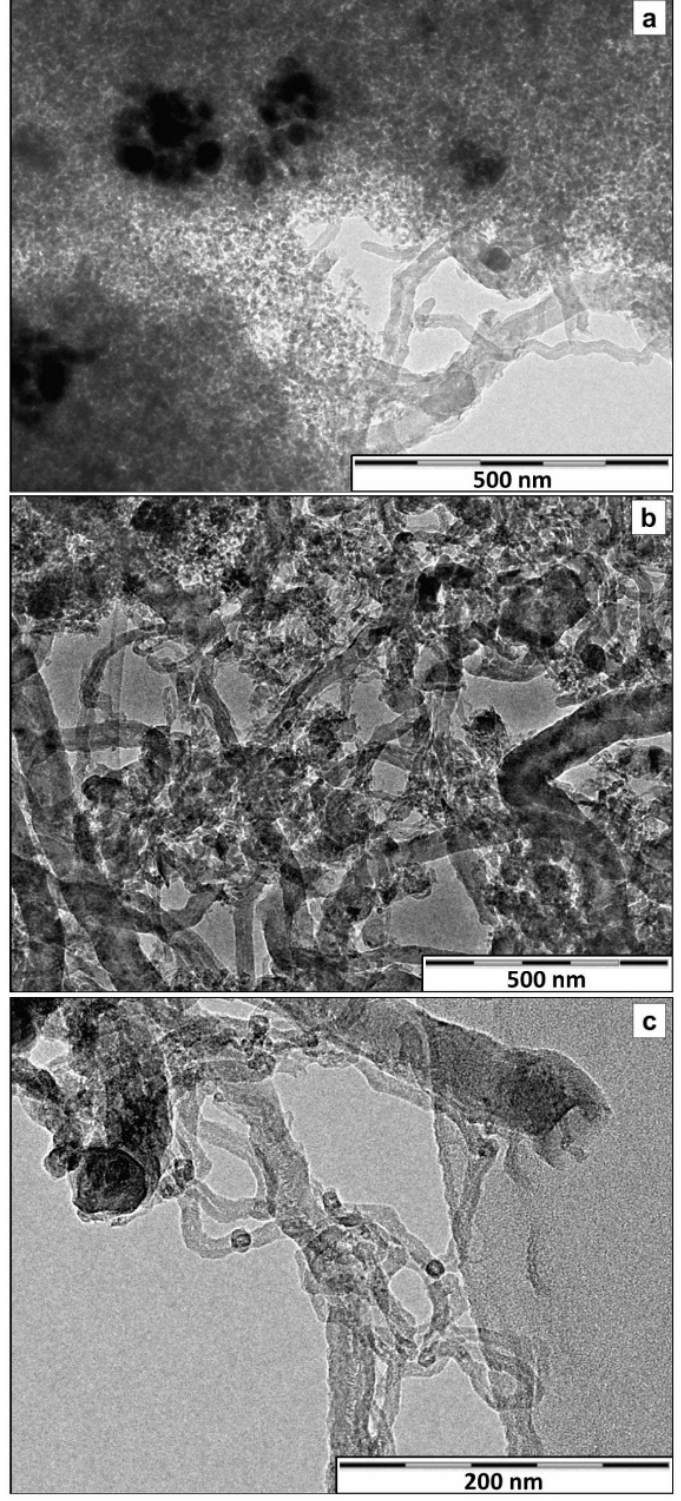
Figure 6. TEM image of coke formed on catalysts after being used for ethanol steam reforming for 8 h: ( a ) Ni/S; ( b ) Ce/NiS; ( c )